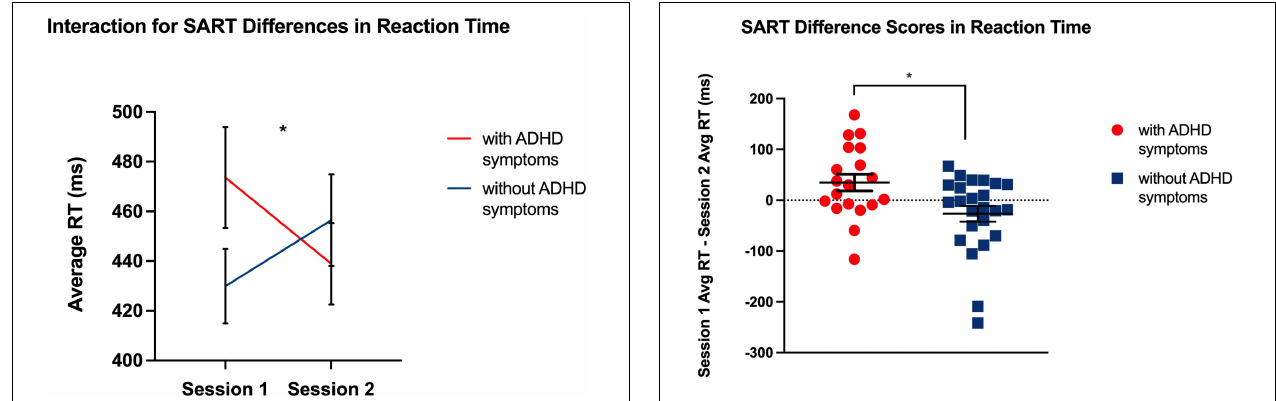
FIGURE 1 | Graph showing a significant interaction effect for Session × Group. As a result, response latency for individuals with ADHD was greater in Session 1 than in Session 2 than for neuro-typical individuals. * p < 0.05, two-tailed.